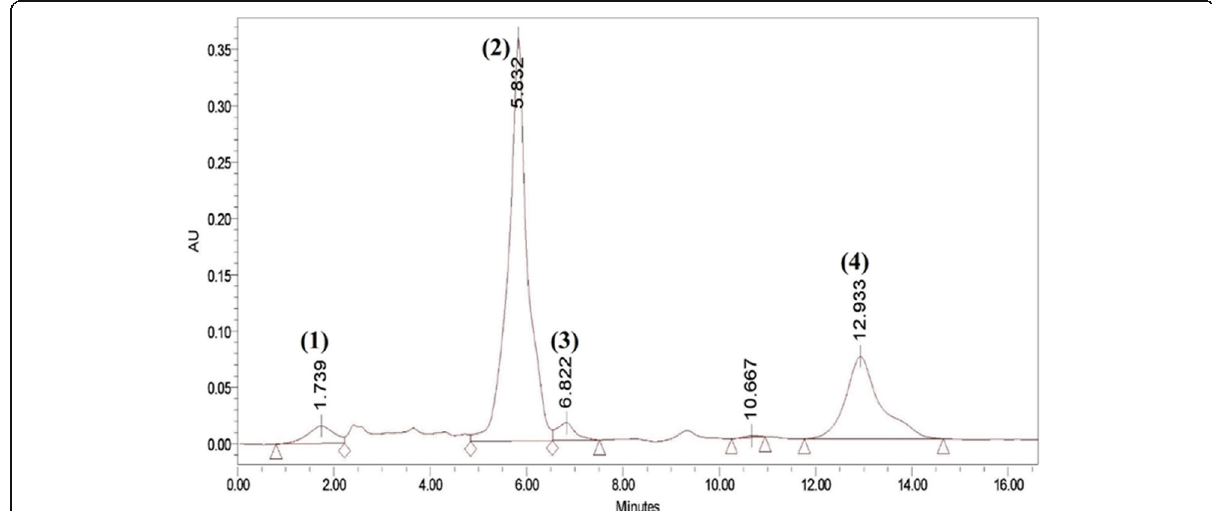
Fig. 4 HPLC chromatogram of methanolic extract of Andrographis paniculata whole plant